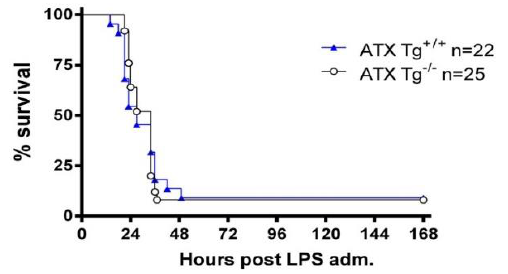
Figure 3. No difference in the survival rates of Enpp2 -Tg mice overexpressing autotaxin. Kaplan – Meier survival curves of Enpp2 -Tg mice and appropriate littermate controls. The presented results are cumulative from two independent experiments. No statistically significant differences were observed, as assessed with the Logrank test.